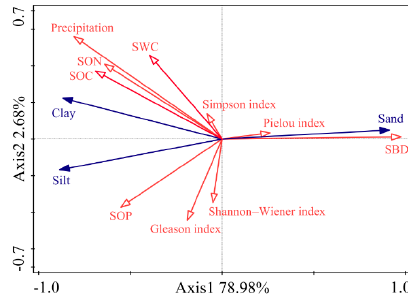
Figure 5. Ordination plots of the results from the redundancy analysis (RDA) to identify the correlations among the PSD (blue arrows), vegetation characteristics, and soil properties (red arrows) on a regional scale. SOC, stock of soil organic carbon; SON, stock of total nitrogen; SOP, stock of total phosphorus.